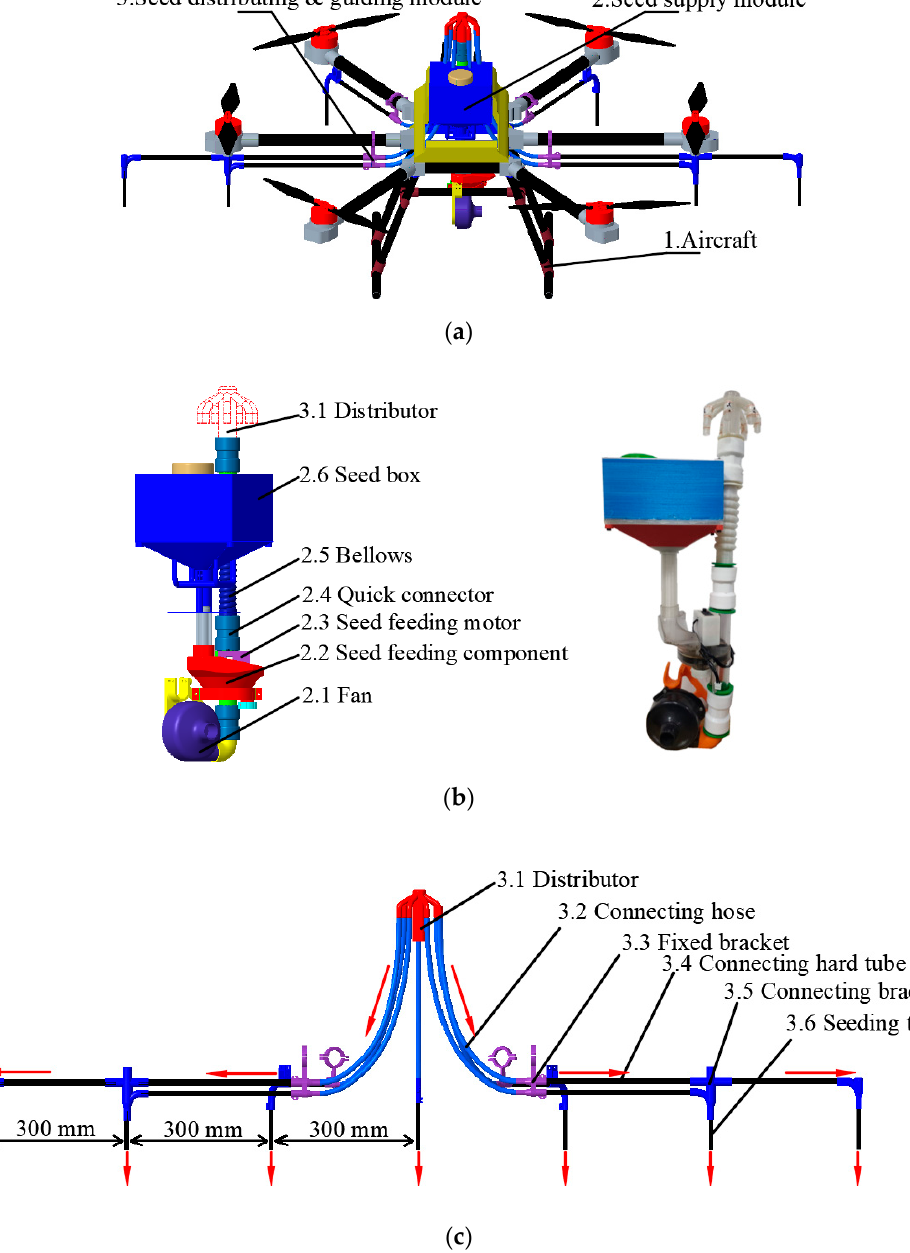
Figure 1. An aerial seeding system for rapeseed based on a multi-rotor UAV and an air-assisted centralized metering device: ( a ) Overall structure; ( b ) Seed supply module and real device; ( c ) Seed distributing and guiding module.